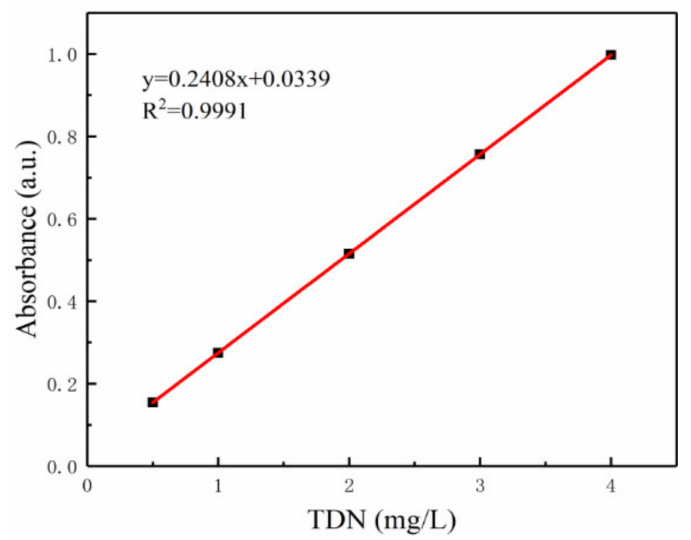
Figure 3. Calibration curve of